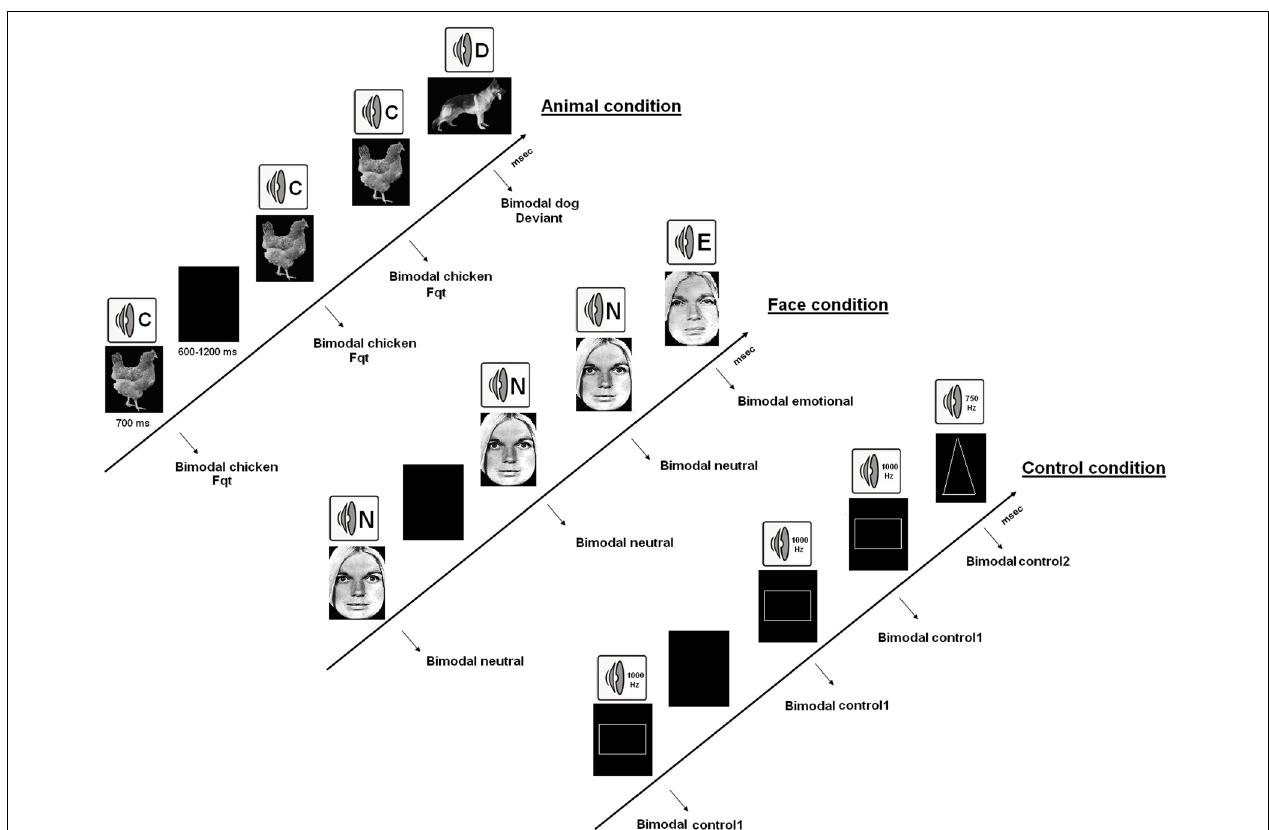
FIGURE 1 | The 3 kinds of bimodal oddball tasks. AVA, which combined synchronized presentations of animal pictures and sounds; AVE, which combined faces and voices displaying neutrality or sadness; and the AVN control condition, which used simple geometrical figures and sounds.